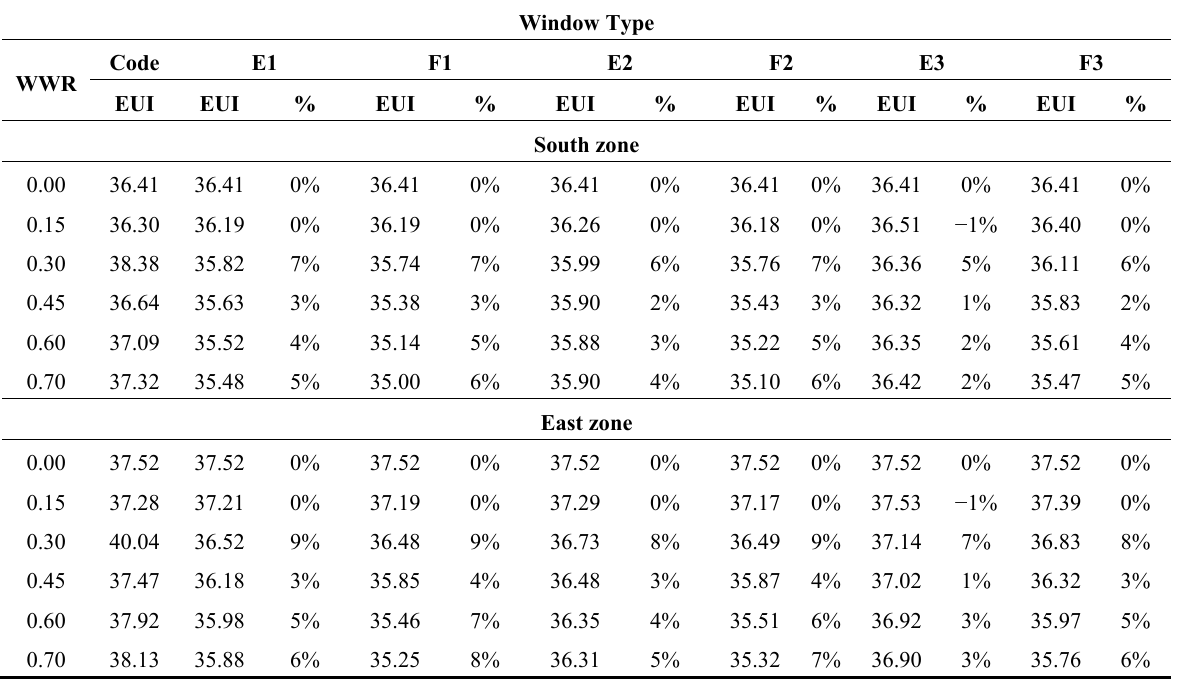
Table 13. Boiler electricity consumption (MJ/m 2 -year) and percent savings compared to the GB 50189-2005 Standard for